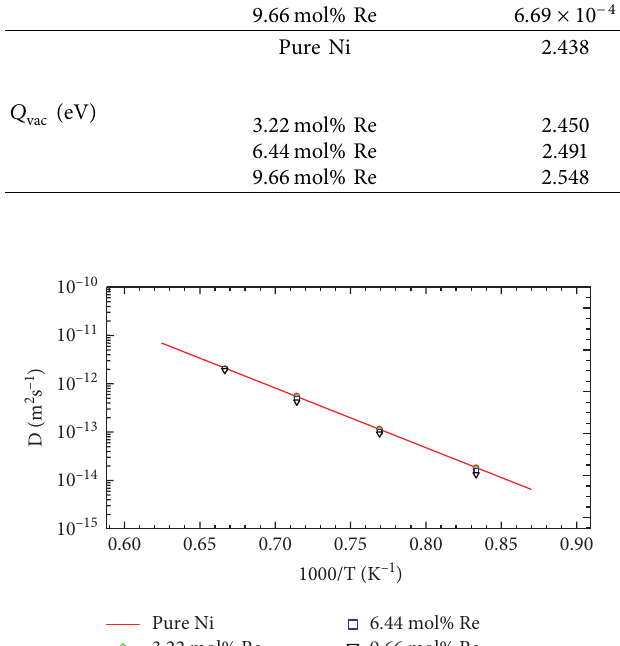
Figure 6: Vacancy diffusion coefficients for T � 1200K, 1300K, 1400K, and 1500K as the amount of Re atoms in the supercell